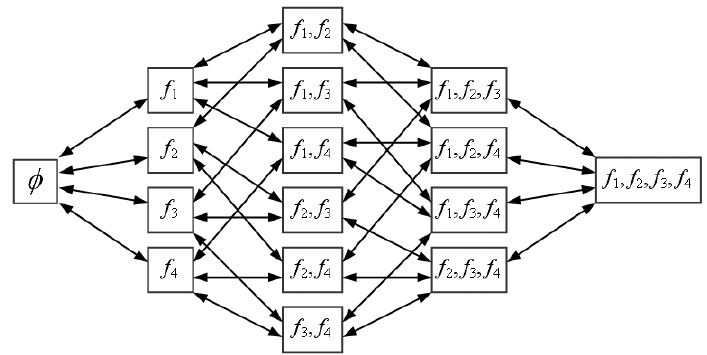
Figure 1. A small example of completely predefined candidate model